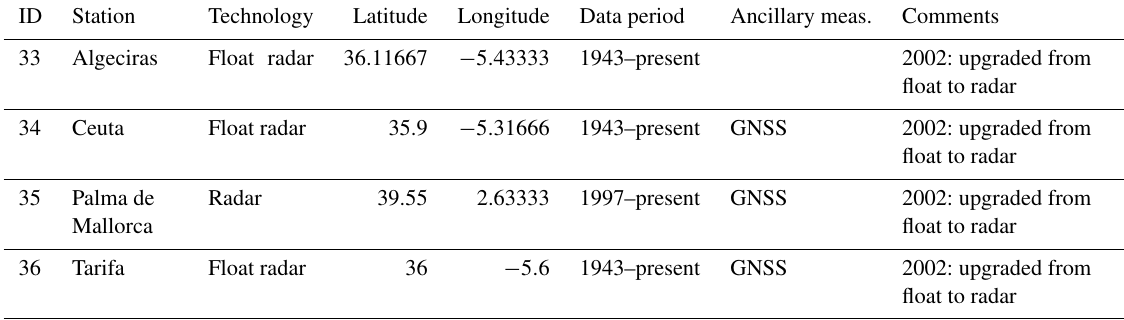
Table A4. Stations operated by Spanish Institute of Oceanography in the Mediterranean Sea and data availability.